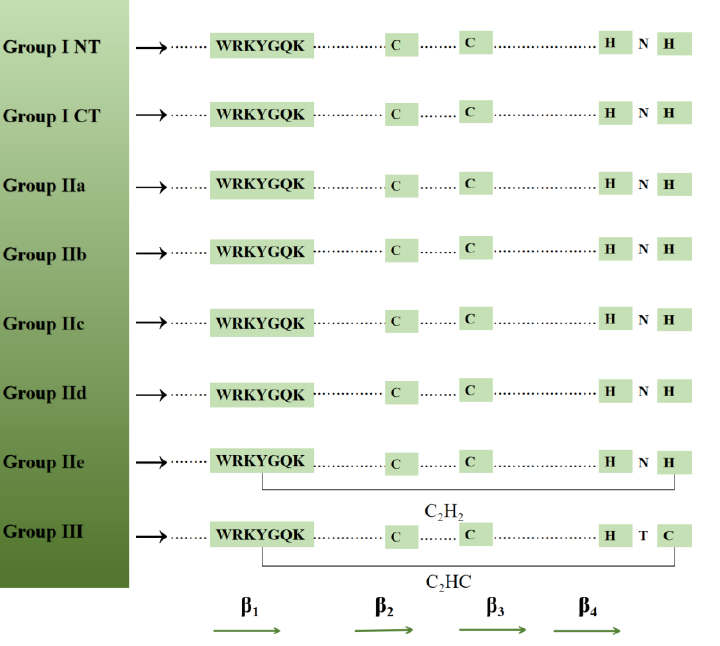
Figure 1. The WRKY domain. The WRKY motif as well as the cysteine and histidine residues that form zinc fingers are shown. Four β -chains are indicated by arrows. Group I NT and CT represent the N-terminal and C-terminal WRKY domains of Group I WRKY proteins.